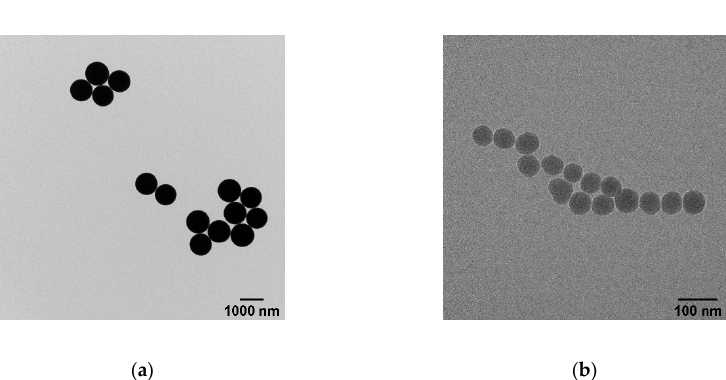
Figure 1. Characterization of the silica (SiO 2 ) particles. ( a ) Representative transmission electron micrographs (TEM) of 920-nm-size SiO 2 -Cy5 (Cyanine 5) microparticles. ( b ) Representative TEM of 59-nm-size SiO 2 -BDP FL (BODIPY ® -fluorescein) nanoparticles (NPs). Table 1. Representation of the main physicochemical characteristics of silica (SiO 2 ) particles.